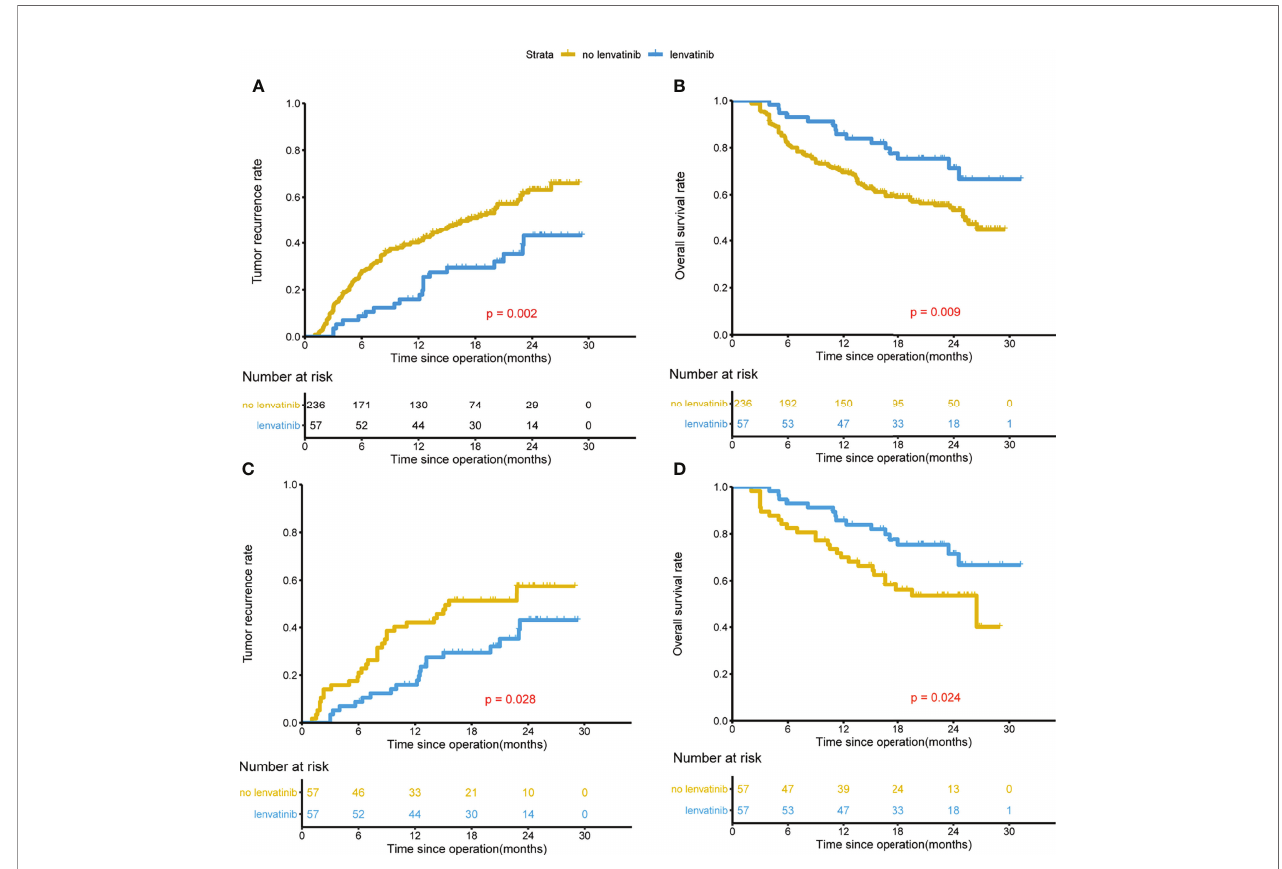
FIGURE 1 | Kaplan-Meier analysis for predicting survival in HCC patients with MVI after radical resection. Before PSM, TTR and OS for patients with and without adjuvant Lenvatinib (A, B) . After PSM, TTR and OS for patients with and without adjuvant Lenvatinib (C, D)